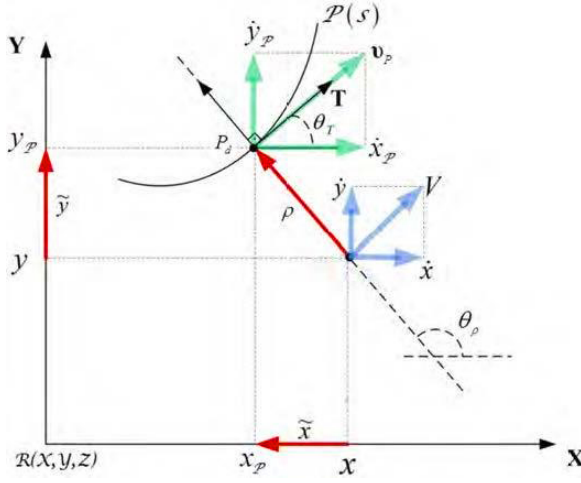
Figure 8: Diagrammatic schema from